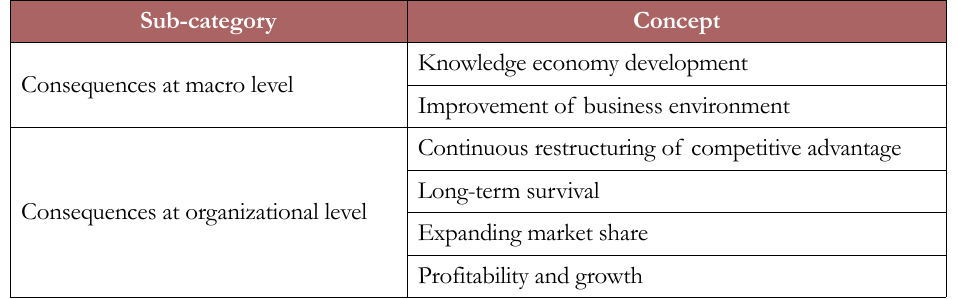
Table 8. Concepts and categories of